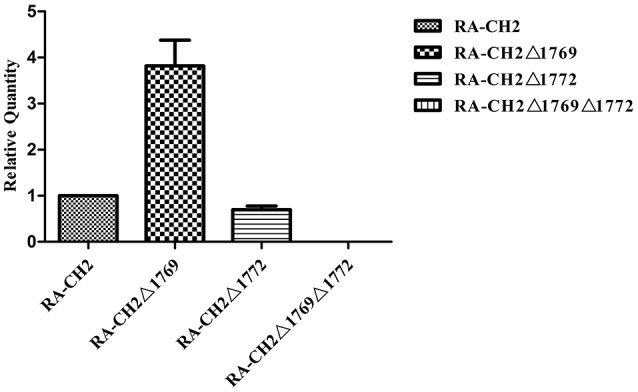
Real-time RT-PCR analysis of cat gene expression in the RA-CH2, RA-CH2Δ1769, RA-CH2Δ1772, and RA-CH2Δ1769Δ1772 strains. The changes of mRNAs were expressed as fold expression and calculated using the comparative CT (2−ΔΔCT) method. The error bars represent the standard deviation of three independent experiments.